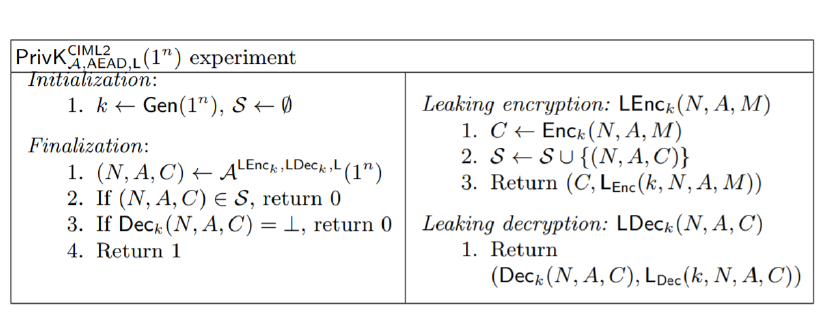
Figure 12: The CIML2 security